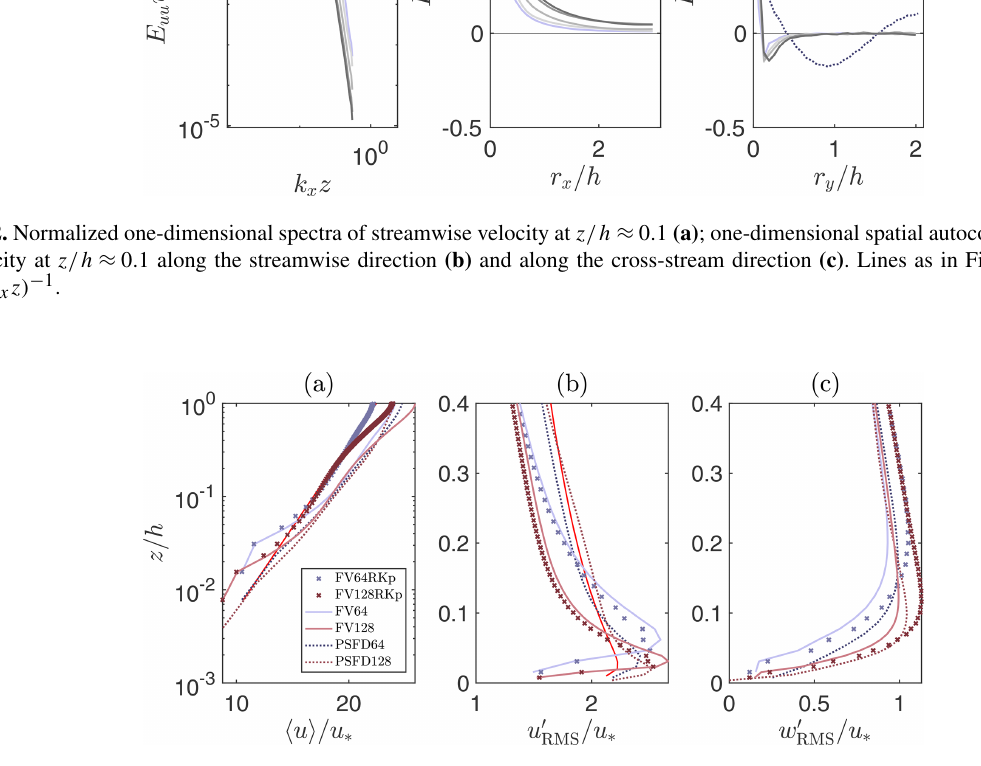
Geosci. Model Dev., 14, 1409–1426,